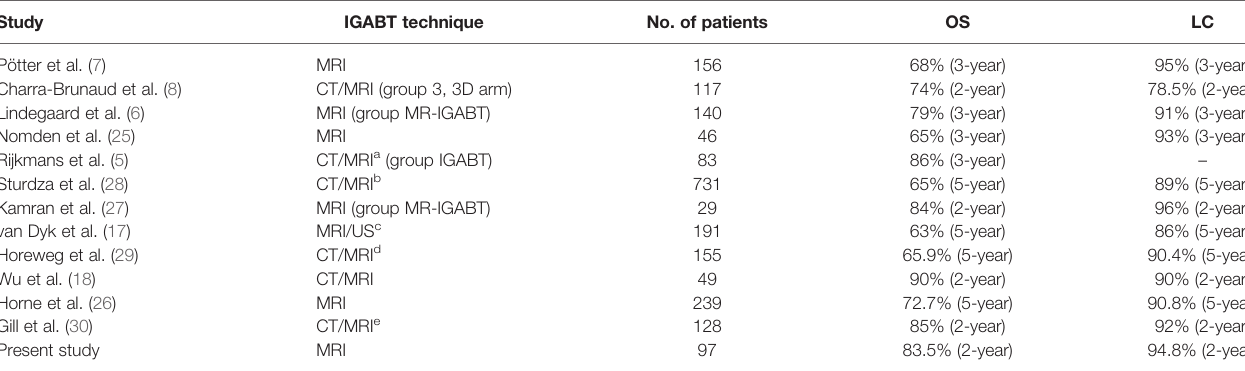
TABLE 7 | Clinical outcomes of IGABT reported in